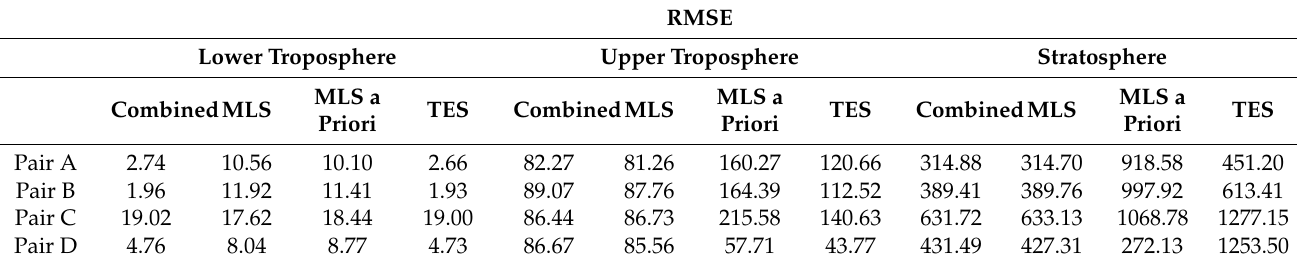
Table 4. RMSEs of ozone profiles from satellites and ozonesonde in lower troposphere